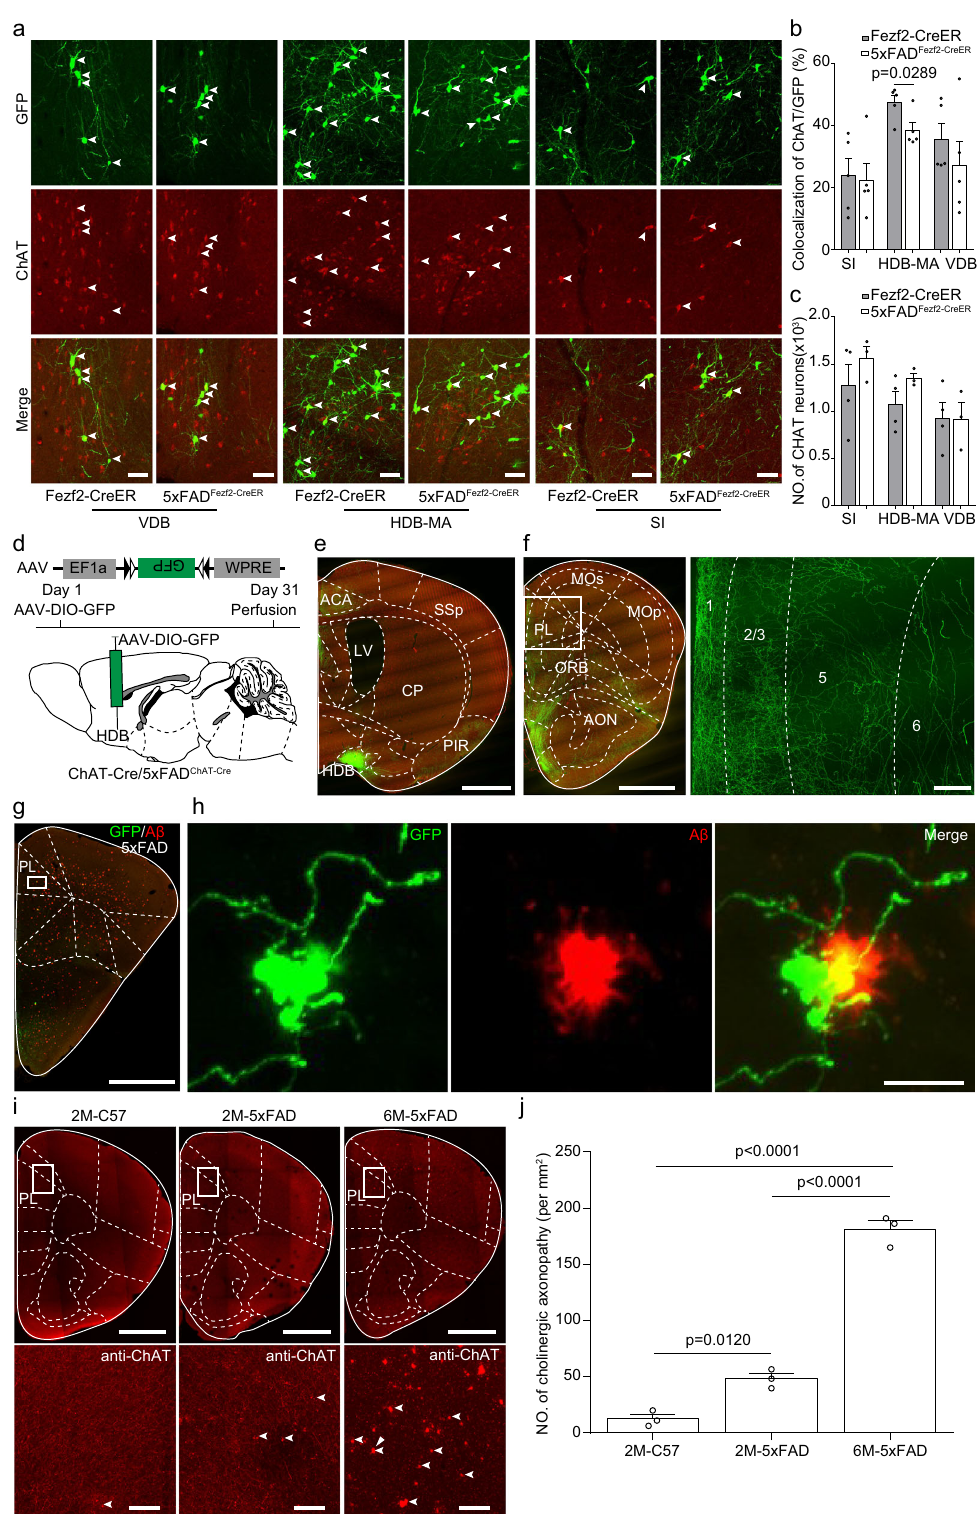
Functional acetylcholine de fi ciency to ET neurons in the mPFC of 5×FAD mice . Our RV tracing results indicated that the ET neurons in the mPFC of 5×FAD mice received fewer cholinergic inputs compared to those of wild type mice. However, the RV tracing mainly re fl ected the structural alteration, we still need to further investigate whether the functional connectivity between cholinergic neurons and ET neurons in the mPFC was